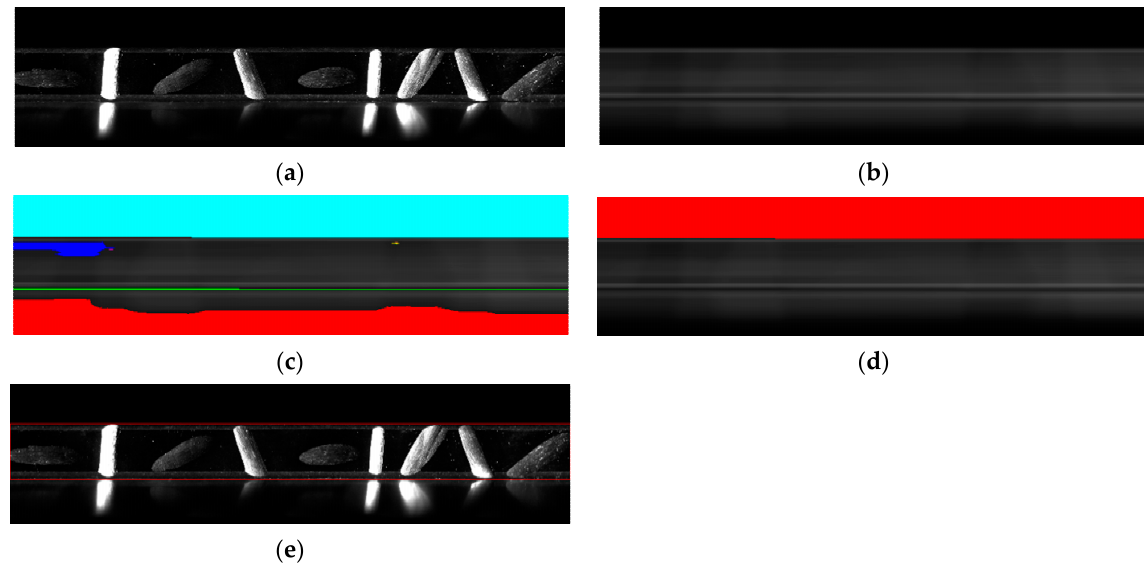
Figure 3. Feature location region-of-interest (ROI) extraction process: ( a ) original image; ( b ) filtered image; ( c ) region after conversion into binary; ( d ) dark background region; ( e ) ROI extraction result.